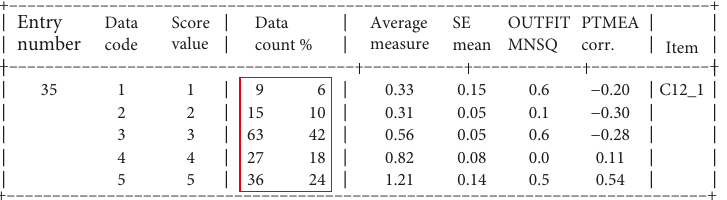
Figure 5: Item category for question